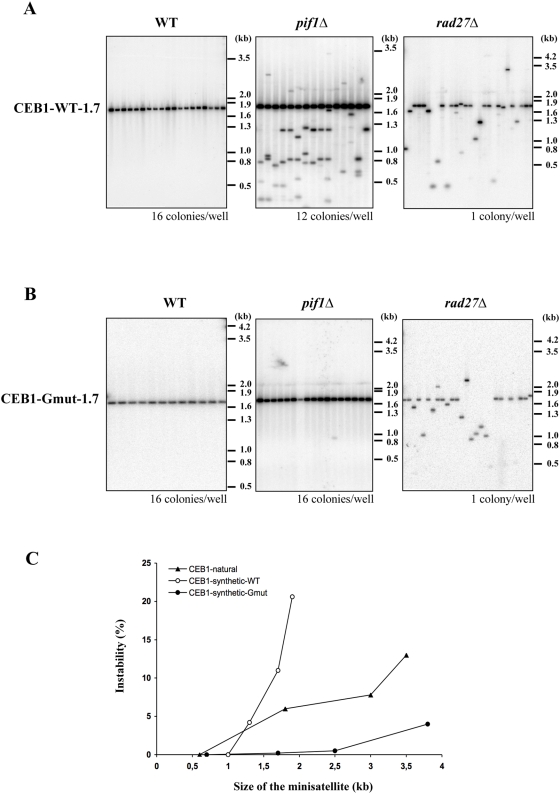
CEB1 instability in pif1Δ cells depends on its potential to form G4 DNA.Comparison of synthetic-CEB1-WT-1.7 (A) and synthetic-CEB1-Gmut-1.7 (B) instability in WT, pif1Δ and rad27Δ haploid strains by Southern blot analysis. In order to increase the number of independent colonies analyzed in pif1Δ and WT strains, colonies are pooled for DNA extraction and the number of colonies analyzed per well is indicated under each gel. DNA is digested by ApaI/SpeI and hybridized with a CEB1-WT or CEB1-Gmut probe. When several rearranged minisatellites migrate at the same size they are considered as clonal and are counted only one time. The frequency of instability for each synthetic minisatellite is reported in Table 3. (C) Frequency of natural and synthetic CEB1 minisatellites according to the size of the alleles in pif1Δ cells.